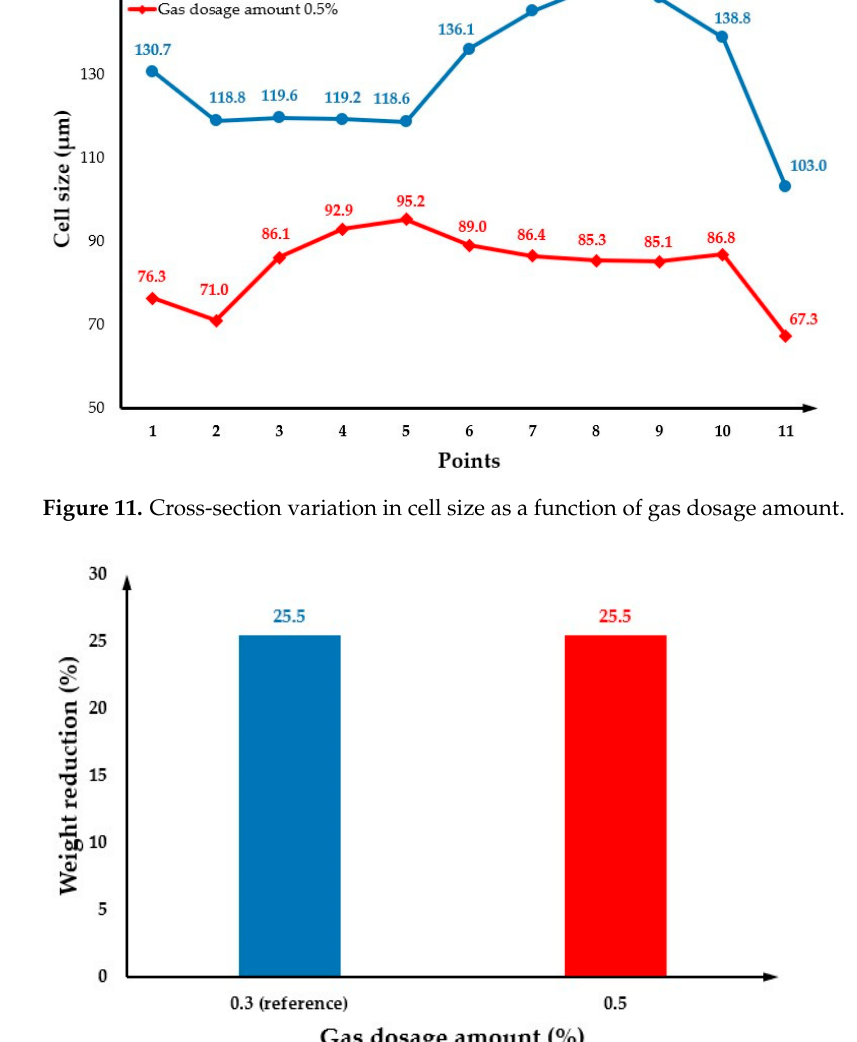
Figure 12. The weight reduction as a function of gas dosage amount.